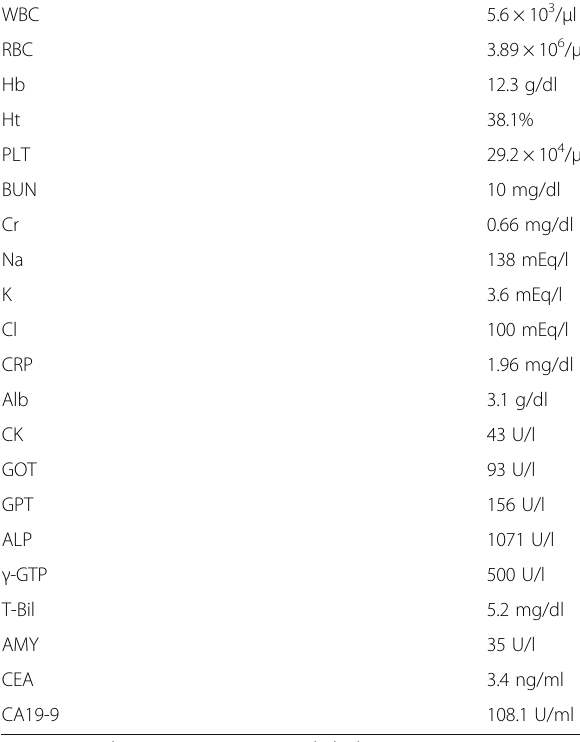
Table 1 Laboratory data on